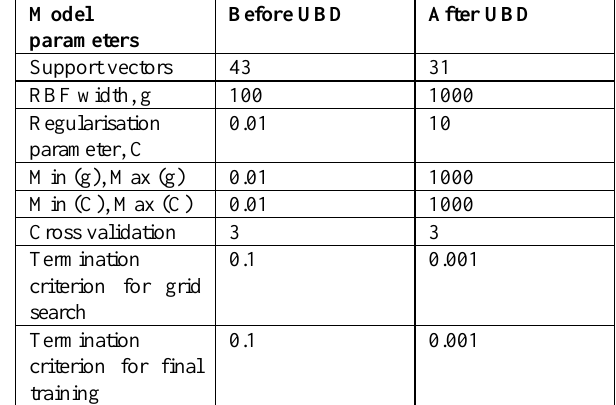
Table 2. Model parameters used to run Support Vector Machines utilising the universal Gaussian radial basis function kernel (RBF) for both experiments; before and after the application of Unmixing-based Denoising (UBD). Min and Max report the minimum and maximum values which define the grid range (g and C dimension). A multiplier of 10 is set for grid range for both